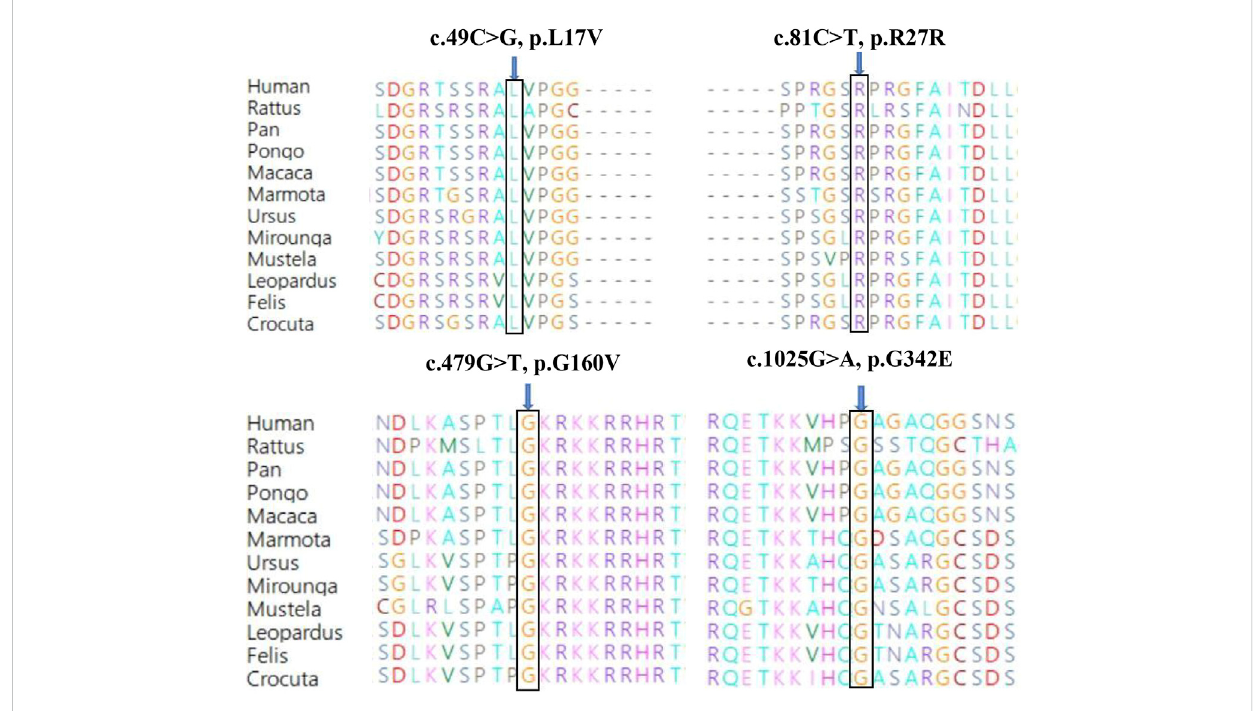
FIGURE 2 Conservation analysis revealed evolutionary conservation of the VSX1 variants.Amino acid sequence alignment of the human VSX1 protein with other species. Leu 17, Arg 27, Gly 160 and Gly 342 are shown in blue.